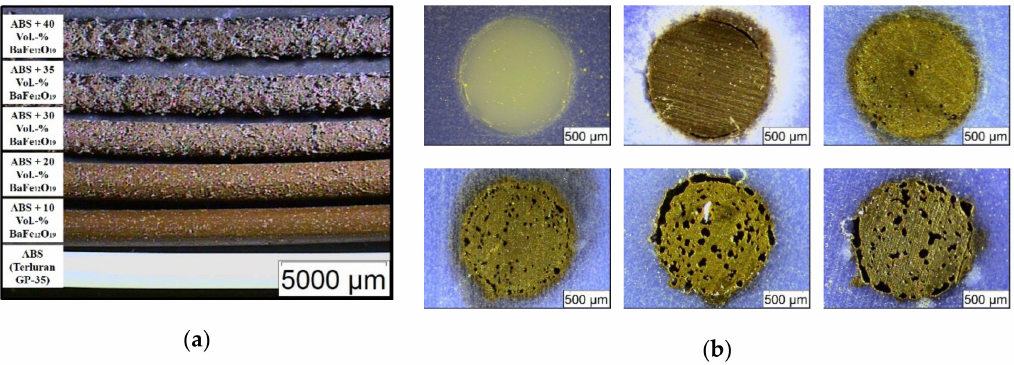
Figure 3. Microscopic images: ( a ) extruded filaments with di ff erent solid loadings; ( b ) polished cross-sections with increasing filler content: 1. Row: Pure acryl butadiene styrene (ABS), 10 vol.%, 20 vol.% ferrite, 2. Row: 30 vol.%, 35 vol.% and 40 vol.%